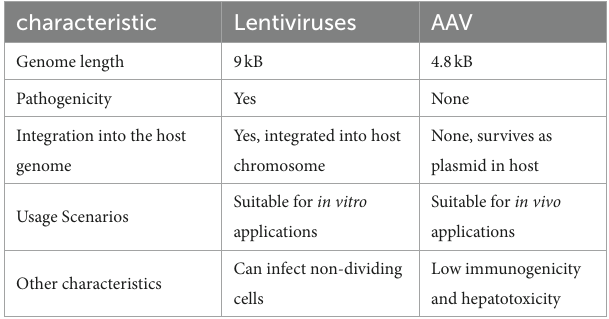
TABLE 1 Comparison between two common vectors used in the clinic: Lentiviruses and adeno-associated virus (AAV). characteristic